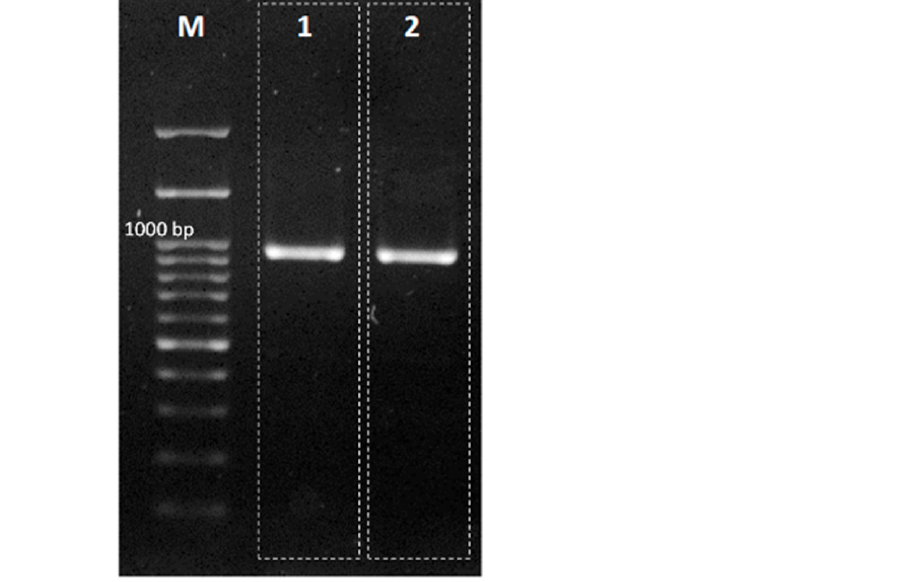
Figure 4. Electrophoresis results of PCR amplification of Bulung Anggur ( 1 ) and Bulung Boni ( 2 ) with tuf A as a primer. Table 3. Barcode alignment for Bulung Boni and Bulung Anggur collected from Bali. The best matched identify with NCBI-BLAST are noted with their GenBank accession number, pairwise dis- tance, and similarity percentage (ID).